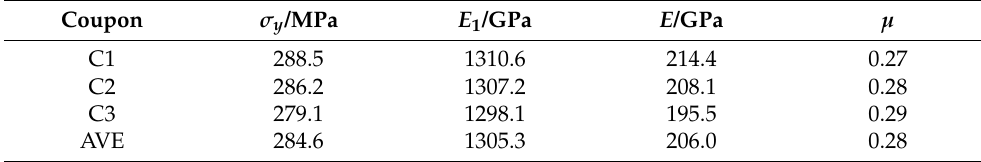
Figure 2. True stress–strain curves of parent material obtained from a uniaxial tensile test [29]. Table 3. Material properties determined from uniaxial tensile test [29].